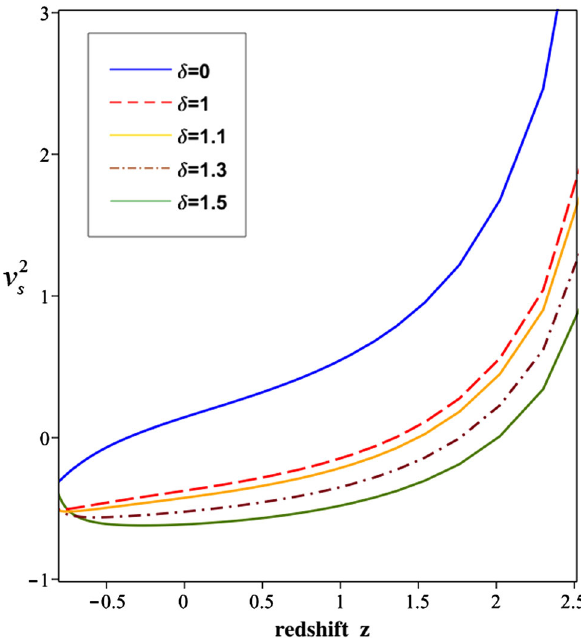
Fig. 5 Plot of squared sound speed of non-interacting THDE model versus redshift z for β 1 = 7 . 1, β 2 = 2 . 15, w = 1000, Ω 0 u = 0 .